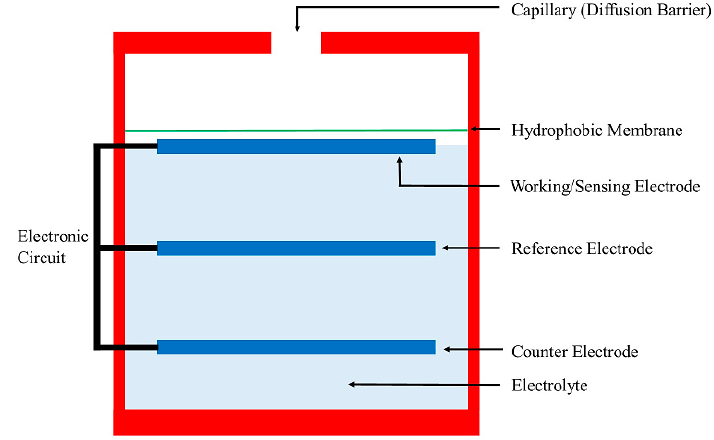
Figure 5. Schematic of an electrochemical